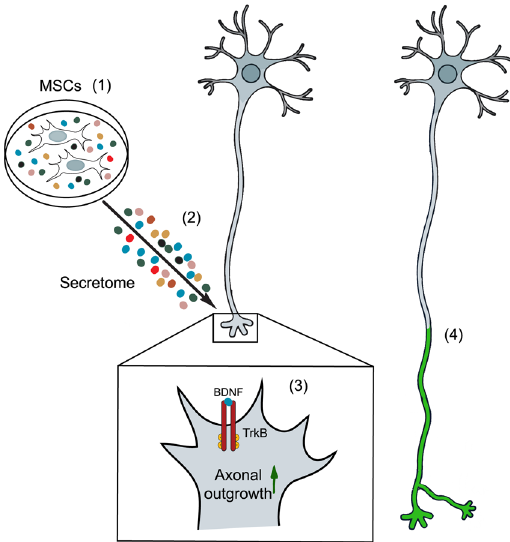
Figure 8. Proposed model for secretome-induced axonal outgrowth. MSCs secretome is composed of a diverse set of molecules, including trophic factors, cytokines, microvesicles and exosomes (1). When the secretome is applied to distal axons (2), BDNF, one of the molecules present, will bind to TrkB present in the membrane of growth cones (3). This interaction leads to the activation of the receptor and downstream signaling